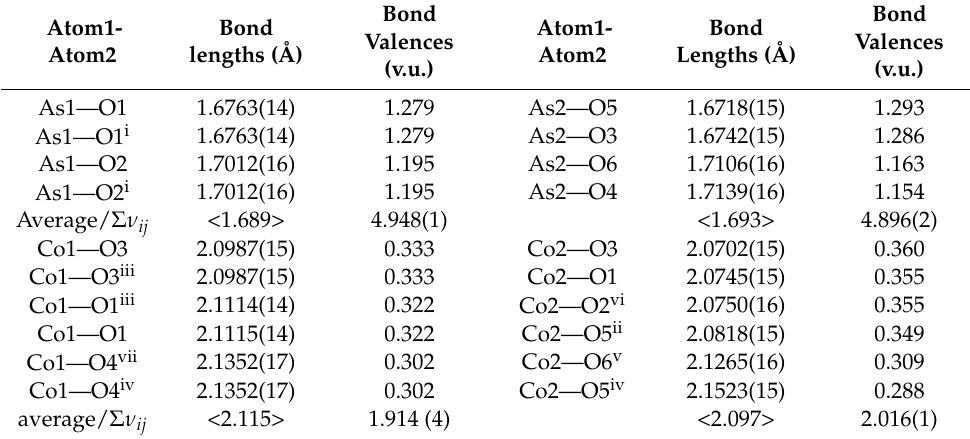
Table 4. Bond lengths (Å), bond-valences and bond valence sums